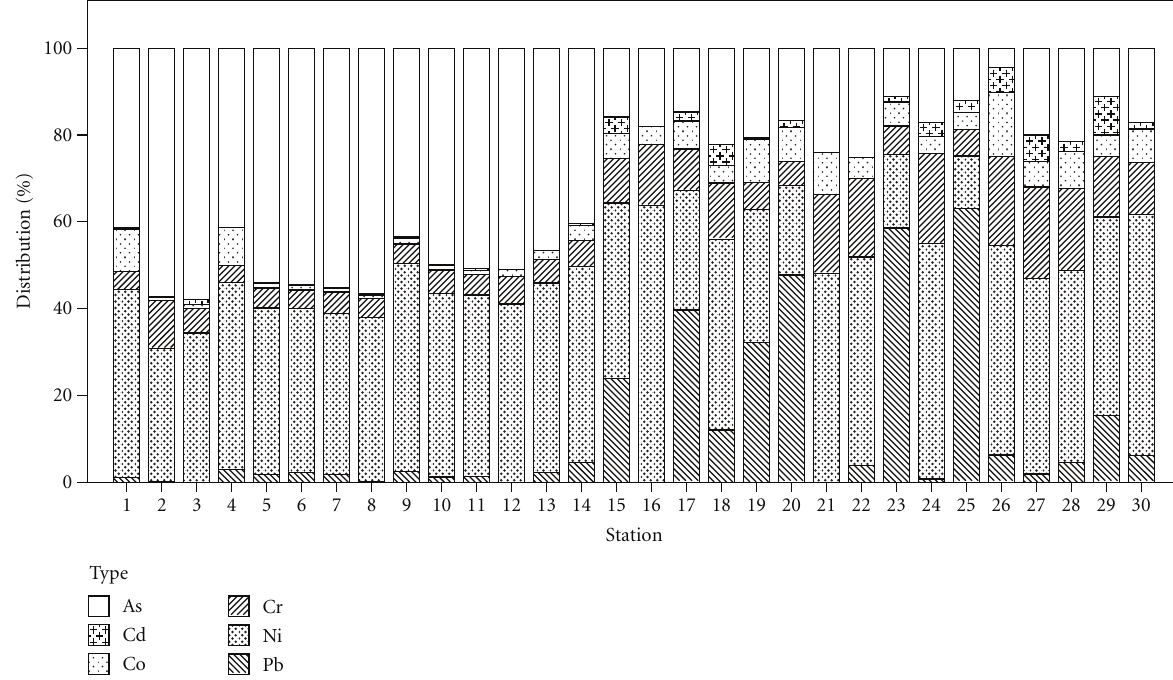
Figure 3: Distribution of metals in water samples from 30 sampling stations at Langat